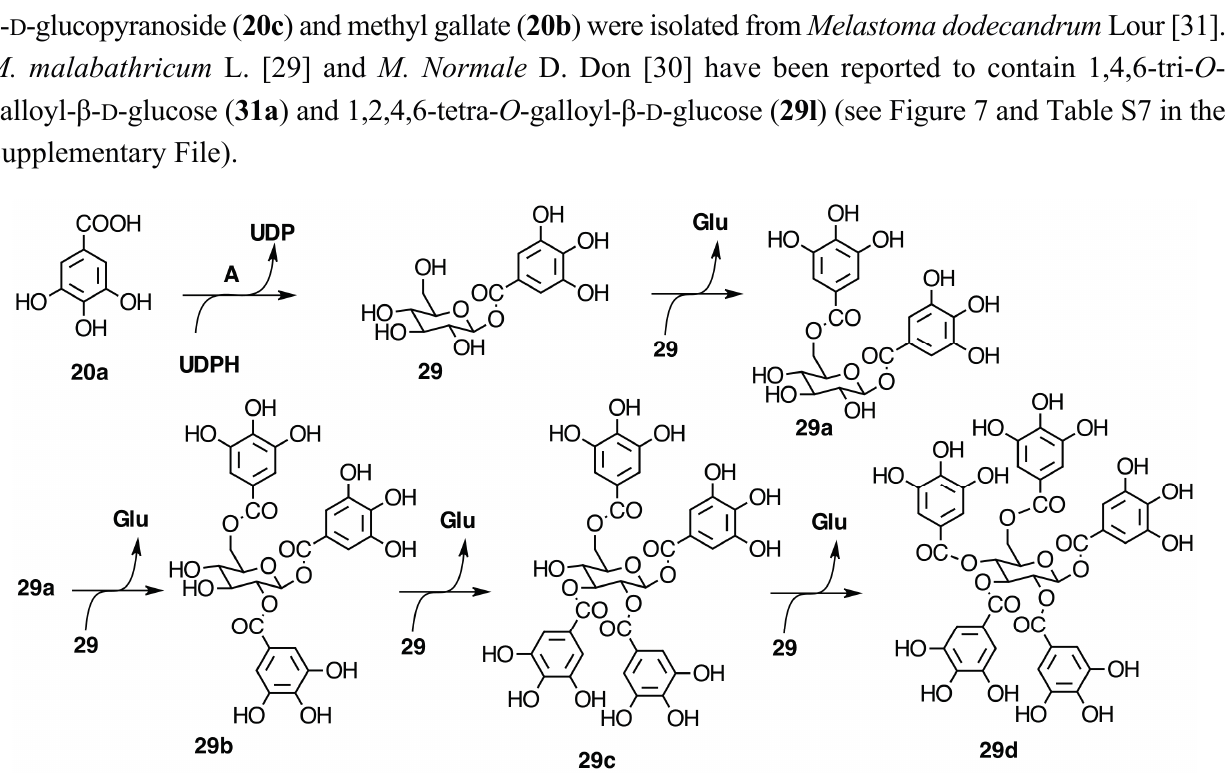
Figure 7. Biosynthesis of galloyl glucoses from gallic acid ( 20a ) and uridin diphosphate glucose. A = UDP-glucose:gallate 1- O -galloyltransferase, UDP = uridine-5 ′ -di-phosphate. In Phyllagathis rotundifolia (Jack) Bl., seven gallotannins were identi fi ed as 6- O -galloyl- D